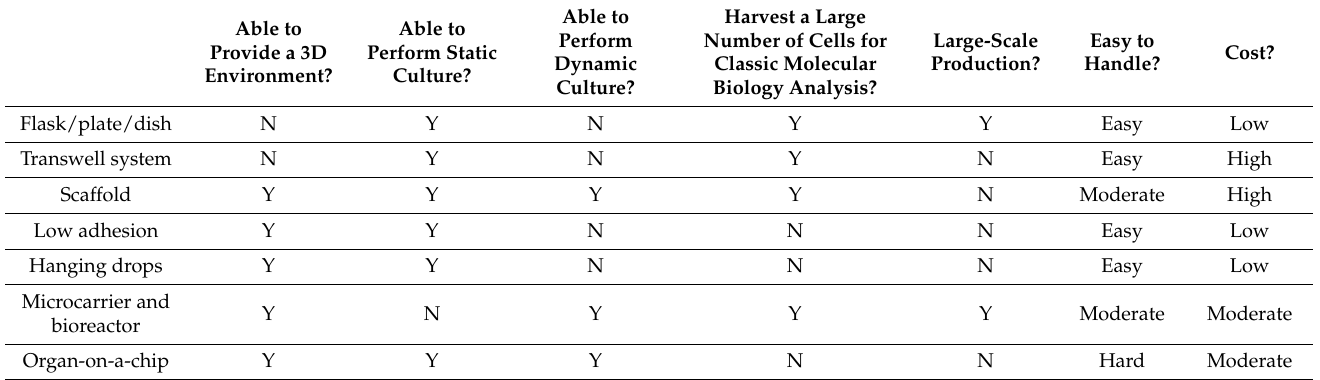
Table 1. A summary of the functions of currently available cell